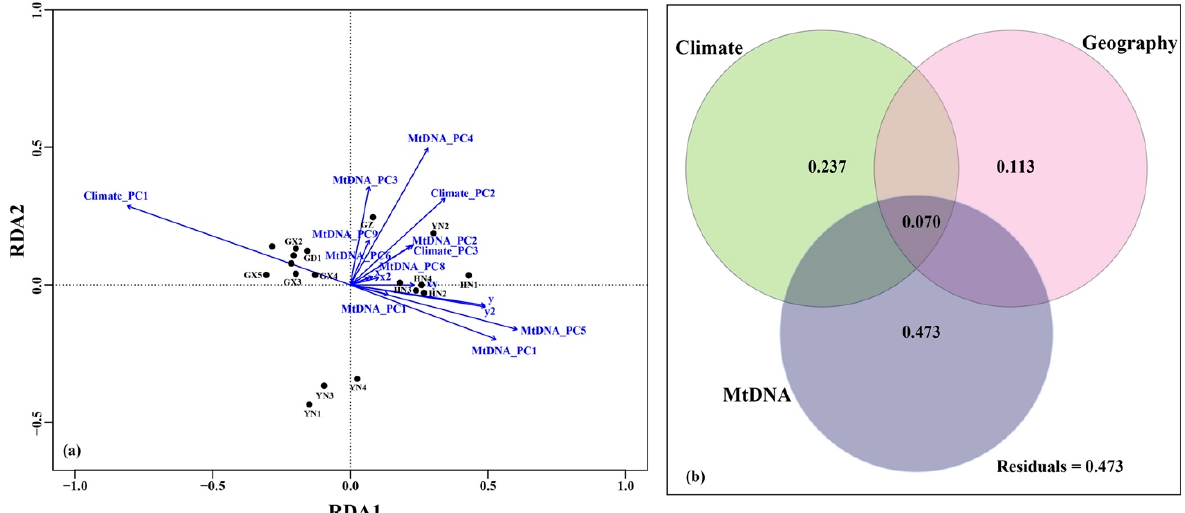
Figure 4. RDA ordination plots ( a ) and a Venn diagram ( b ) of variation partitioning of nuclear divergence in Hipposideros larvatus . Nuclear microsatellites, allele frequency matrices, including 10 principal components (NuDNA_PCs 1–10); climate, climatic distance matrices, including three principal components (Climate_PCs 1–3); geography, spatial distance matrices, including five variables ( x , y , xy , x 2 , y 2 ); MtDNA, mitotype frequency matrices, including nine principal components (MtDNA_PCs 1–9). The explained variation in variation partitioning is based on adjusted R 2 . Values lower than 0 are not shown.